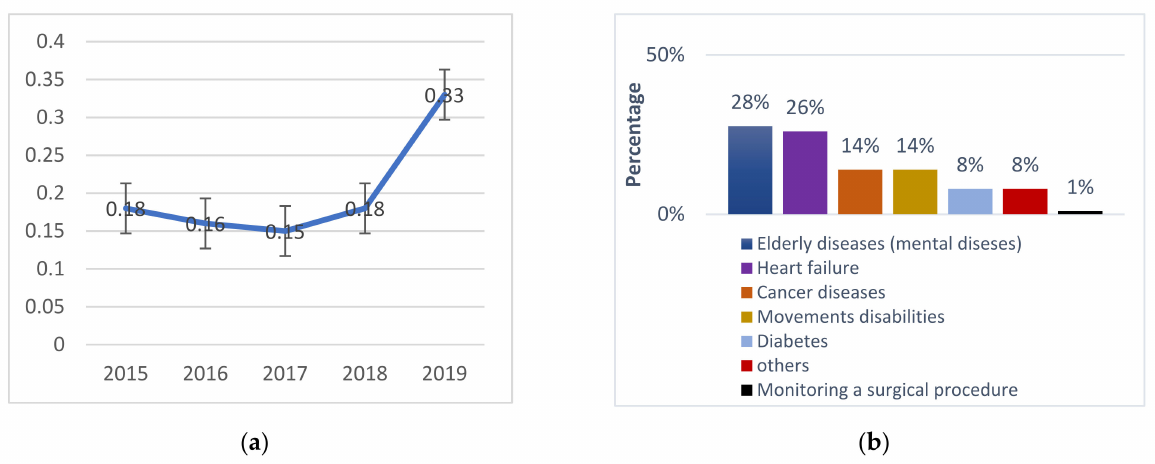
Figure 2. ( a ) Number of articles per year; ( b ) Distribution of RPMs according to